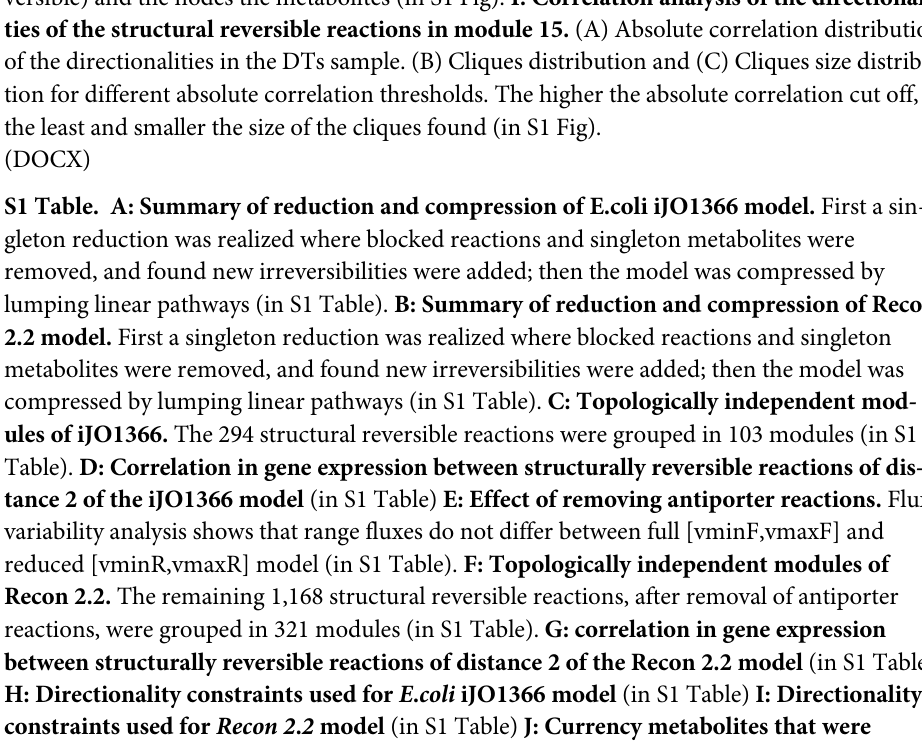
S1 Fig. A: Characterization of Recon 2.2 modules dimensions. Almost half of the generated modules contain one reversible reaction, while 6% of the modules contain 10 or more revers- ible reactions (in S1 Fig). B: Infeasible flux patters of module 15 due to loopless rules. 5 of the 11 infeasible flux patterns are presented, each with a different colour. The arrows represent the reactions in the module (both reversible and irreversible) and the nodes the metabolites (in S1 Fig). C: Infeasible flux patters of module 15 due to loopless rules. 4 of the 11 infeasible flux patterns are presented, each with a different colour. The arrows represent the reactions in the module (both reversible and irreversible) and the nodes the metabolites (in S1 Fig). D: Infeasible flux patters of module 15 due to loopless rules. 2 of the 11 infeasible flux patterns are presented, each with a different colour. The arrows represent the reactions in the module (both reversible and irreversible) and the nodes the metabolites (in S1 Fig). E: Infeasible flux patters of module 15 due to mass balance rules. 14 of the 15 infeasible flux patterns are pre- sented, each with a different colour. The arrows represent the reactions in the module (both reversible and irreversible) and the nodes the metabolites (in S1 Fig). F: Infeasible flux patters of module 15 due to mass balance rules. 1 of the 15 infeasible flux patterns are presented, each with a different colour. The arrows represent the reactions in the module (both reversible and irreversible) and the nodes the metabolites (in S1 Fig). G: Infeasible flux pattern of mod- ule 15 due to two metabolites mixed mass balance rules. The infeasible pattern is highlighted using red arrows. The arrows represent the reactions in the module (both reversible and irre- versible) and the nodes the metabolites (in S1 Fig). H: Infeasible flux pattern of module 15 found using the heuristic algorithm. The two infeasible patterns are highlighted using red and blue arrows. The arrows represent the reactions in the module (both reversible and irre- versible) and the nodes the metabolites (in S1 Fig). I: Correlation analysis of the directionali- ties of the structural reversible reactions in module 15. (A) Absolute correlation distribution of the directionalities in the DTs sample. (B) Cliques distribution and (C) Cliques size distribu- tion for different absolute correlation thresholds. The higher the absolute correlation cut off, the least and smaller the size of the cliques found (in S1 Fig). S1 Table. A: Summary of reduction and compression of E.coli iJO1366 model. First a sin- gleton reduction was realized where blocked reactions and singleton metabolites were removed, and found new irreversibilities were added; then the model was compressed by lumping linear pathways (in S1 Table). B: Summary of reduction and compression of Recon metabolites were removed, and found new irreversibilities were added; then the model was compressed by lumping linear pathways (in S1 Table). C: Topologically independent mod- ules of iJO1366. The 294 structural reversible reactions were grouped in 103 modules (in S1 Table). D: Correlation in gene expression between structurally reversible reactions of dis- tance 2 of the iJO1366 model (in S1 Table) E: Effect of removing antiporter reactions. Flux variability analysis shows that range fluxes do not differ between full [vminF,vmaxF] and reduced [vminR,vmaxR] model (in S1 Table). F: Topologically independent modules of Recon 2.2. The remaining 1,168 structural reversible reactions, after removal of antiporter reactions, were grouped in 321 modules (in S1 Table). G: correlation in gene expression between structurally reversible reactions of distance 2 of the Recon 2.2 model (in S1 Table) H: Directionality constraints used for E . coli iJO1366 model (in S1 Table) I: Directionality constraints used for Recon 2 . 2 model (in S1 Table) J: Currency metabolites that